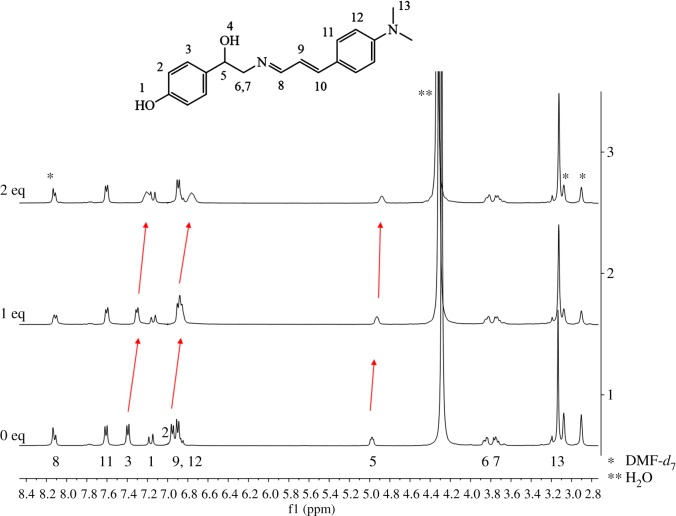
1H NMR titrations of 1 with the addition of S2− (0, 1 and 2 equiv).